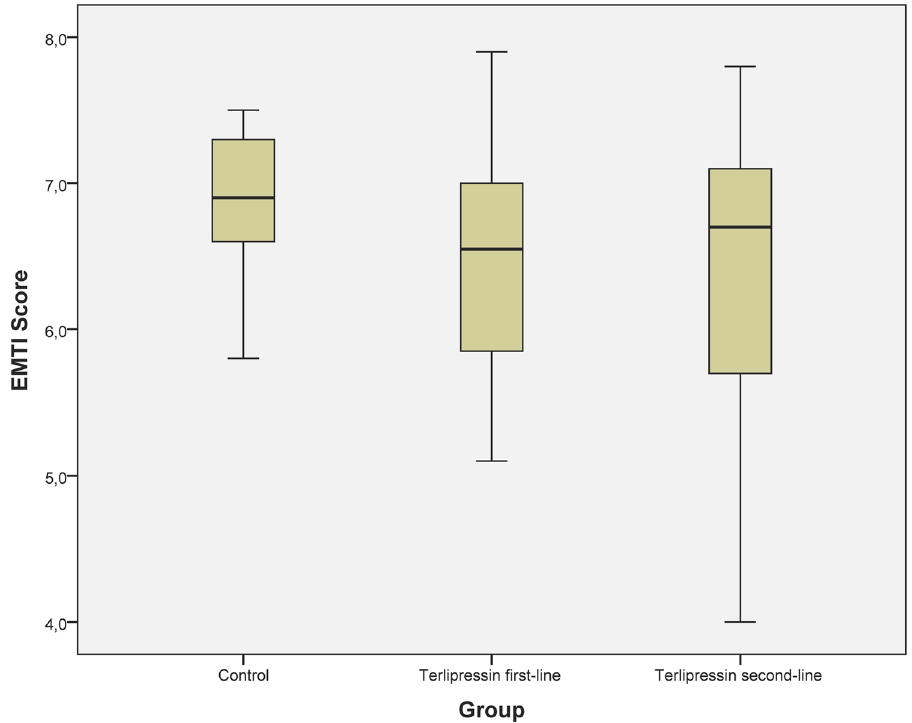
Figure 4. EMTI score of the study animals. The figure demonstrates the electronic microscopy injury (EMTI) score of the animals analysed in kidney biopsies. EMTI, electronic microscopy tubular injury. Data are presented as median [interquartile